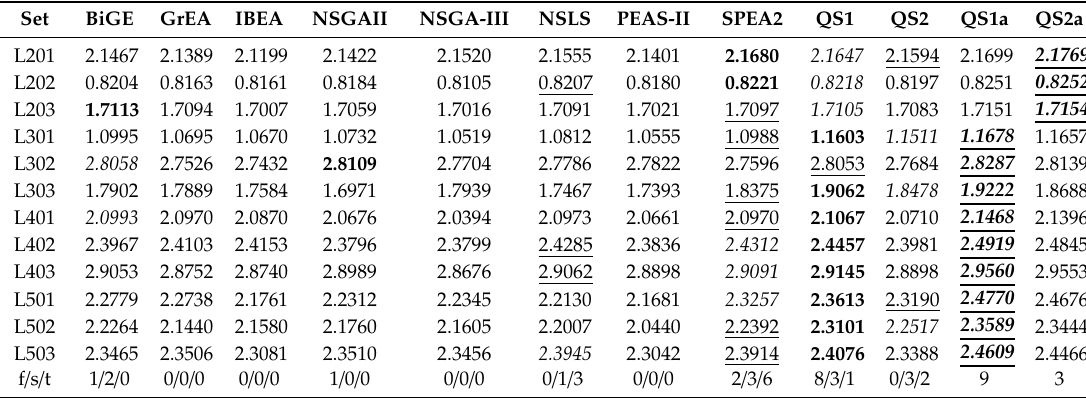
Table 4. Mean HV values of 12 approaches for